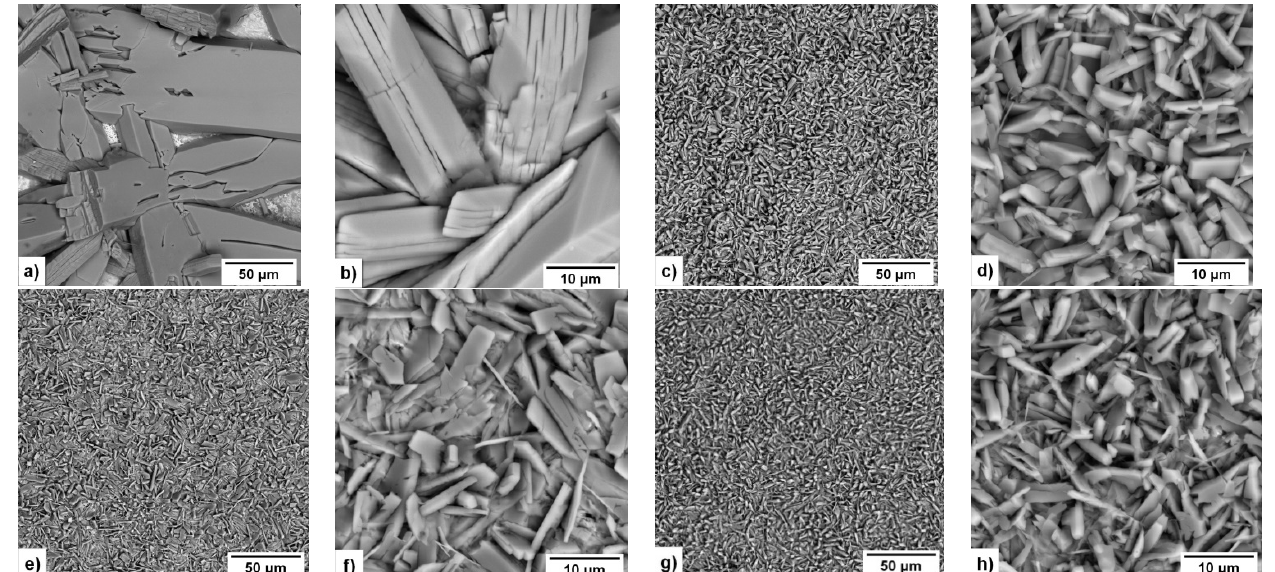
Figure 2. SEM images of 08YU steel with phosphate coatings obtained in solution with different concentration of GO (g/L): 0 ( a , b ); 0.3 ( c , d ); 0.6 ( e , f ) and 1.2 ( g , h ).